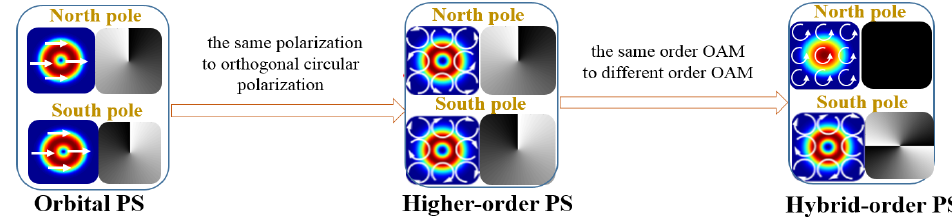
Figure 5. Sketch of the progressive relationship from the orbital Poincaré sphere (PS) to higher-order PS, then to hybrid-order PS.